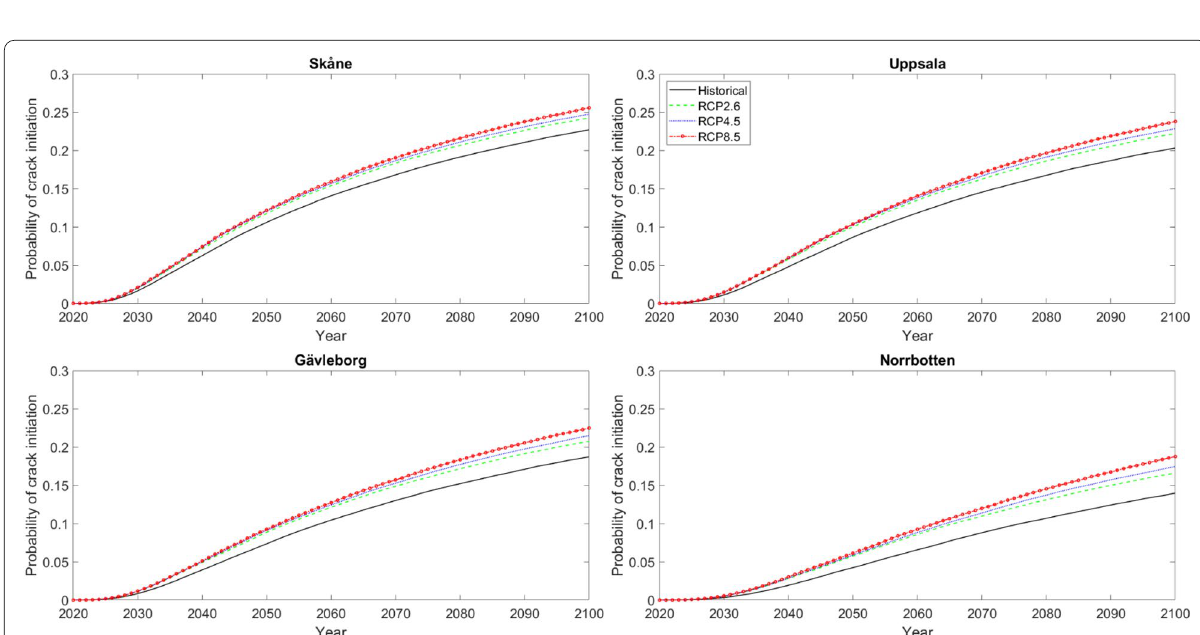
Fig. 6 Probability of crack initiation for the studied beam under the historical (1961 – 1990) and future climatic conditions for Skåne, Uppsala, Gävleborg, and